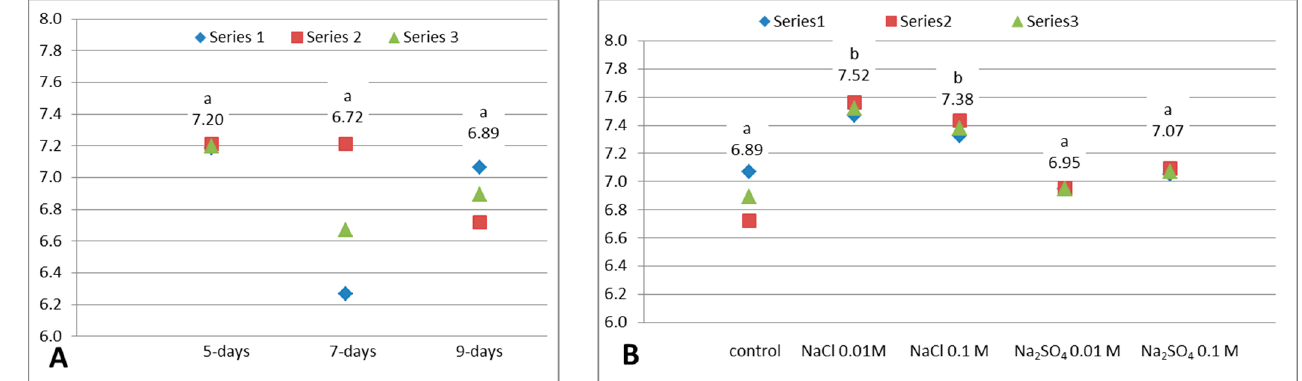
Figure 4. DPPH radical scavenging capacity (DPPH RSC, mg ascorbic acid/100 g FW) of white cabbage microgreens. ( A ). Influence of growth: untreated 5-, 7- and 9-day-old microgreens ( α = 0.05, between groups df = 2, F = 1.618, p = 0.274). ( B ). Influence of NaCl or Na 2 SO 4 treatments on 9-day-old microgreens ( α = 0.05, between groups df = 4, F = 31.515, p = 0.000). Above the data points are displayed the mean values and a letter: different letters denote significant differences between values (Tukey HSD test). Series 1, 2 or 3 from the legend represent the 3 individual